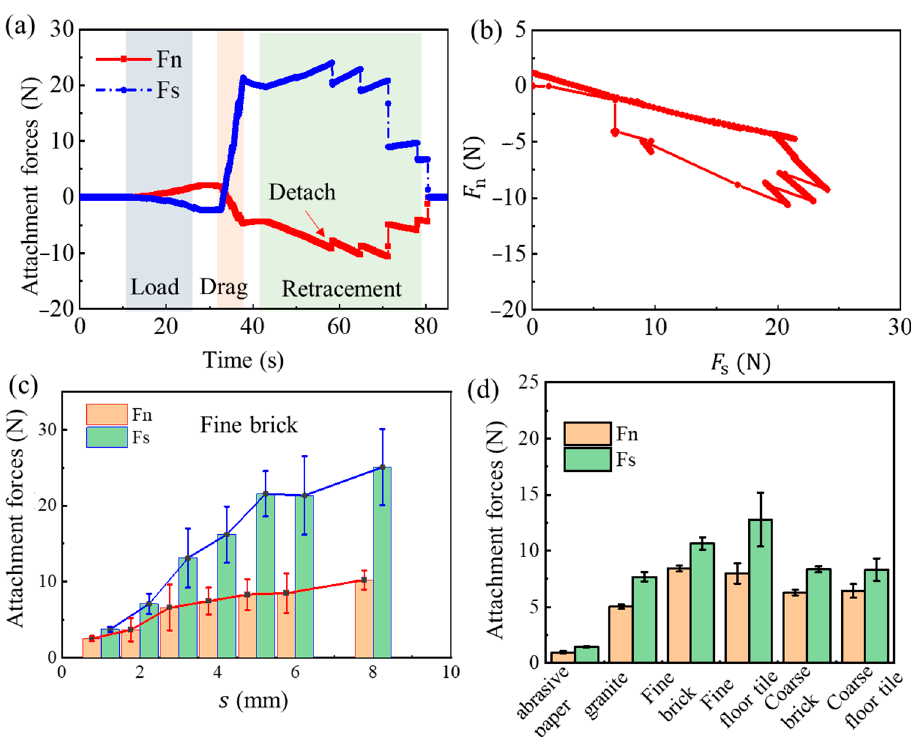
Figure 9. Performance of microspines Gripper. ( a ) Attachment forces test of the spines unit. ( b ) At- tachment forces of the spines unit in force space. ( c ) The relationship between attachment forces and slip distance s . ( d ) Attachment forces of microspines cell on six surfaces.